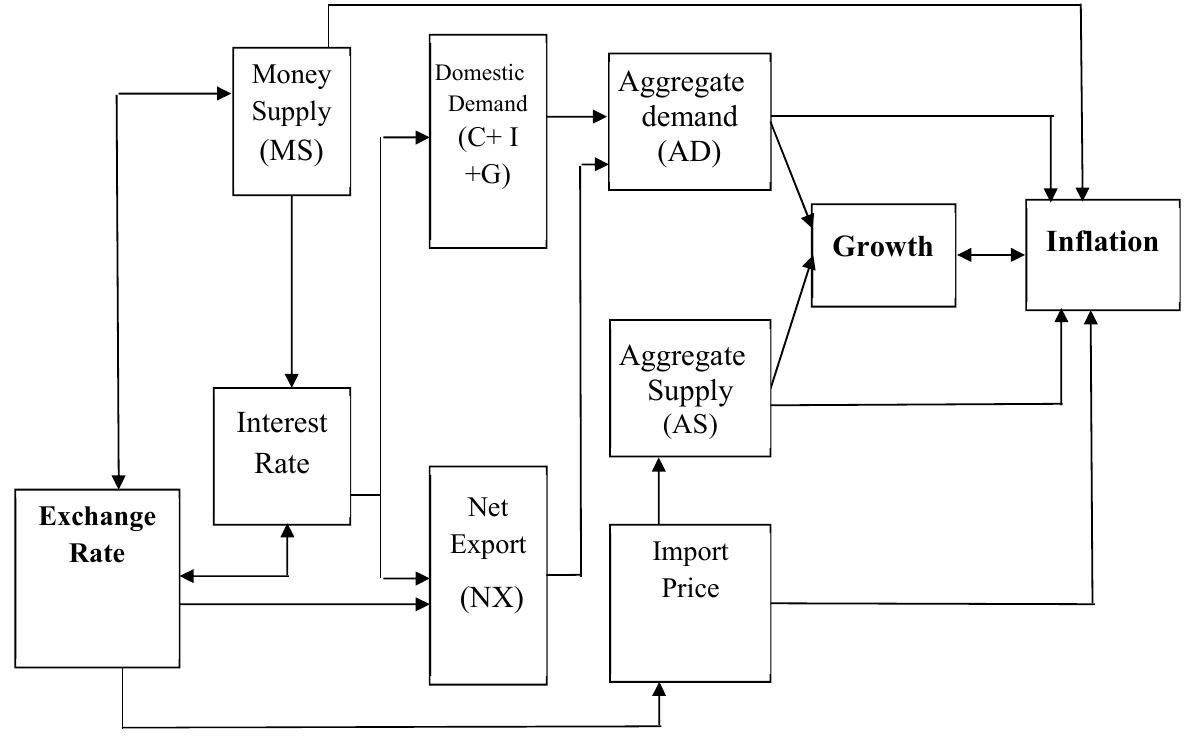
Fig. 1. The impact transmission mechanism of exchange rate on growth and inflation Source: summary of the research